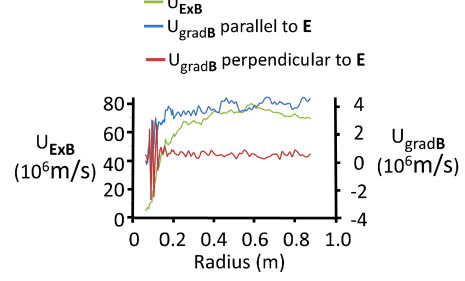
FIG. 26. Guiding center velocities for the top A-K gap.